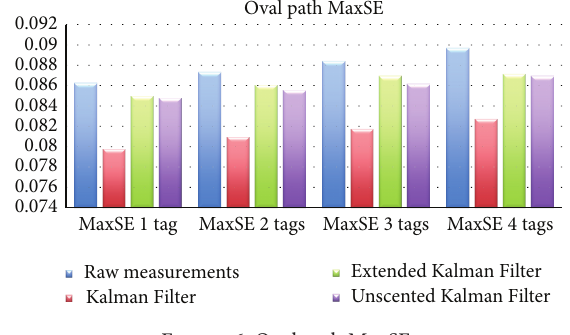
Figure 6: Oval path